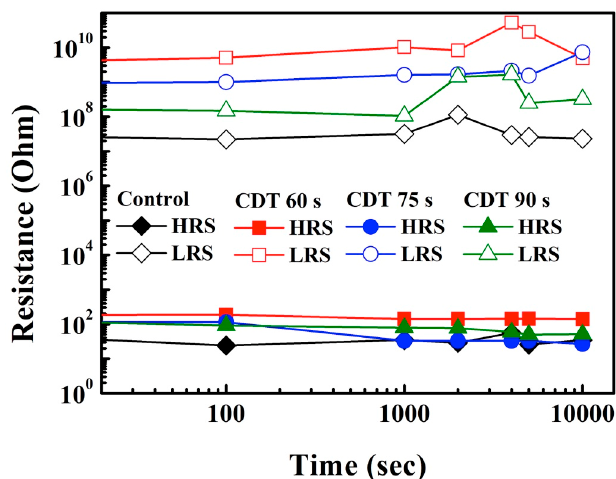
Figure 7. Resistive retention characteristics of the control and Cu-CDT ReRAM devices in the LRS and HRS.